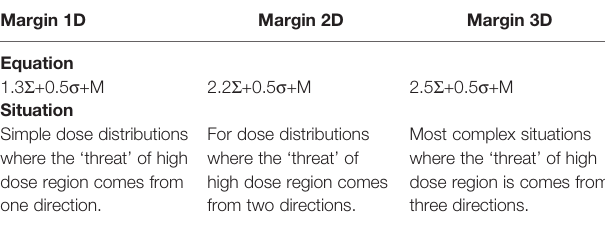
TABLE E1 | Margin proposed by McKenzie [Ref